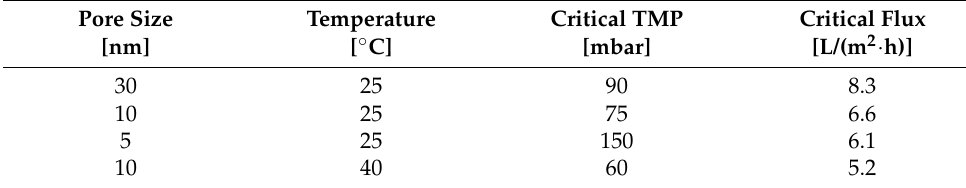
Table 3. Critical flux and TMP for different membrane-pore sizes and temperatures. Pore